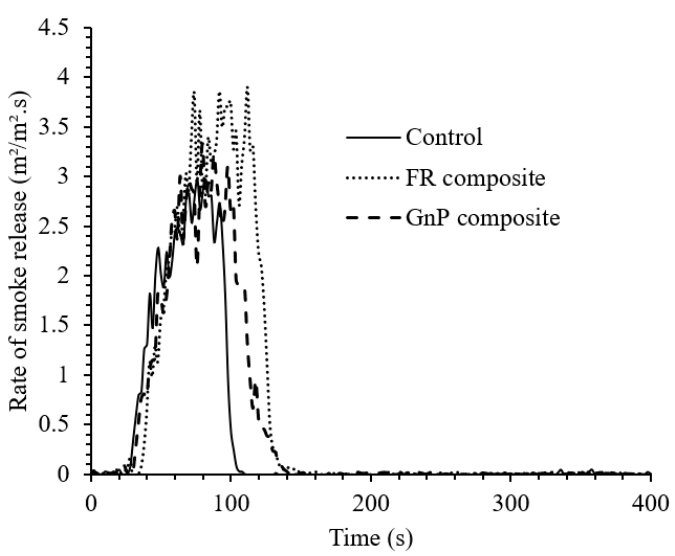
calorimeter test.